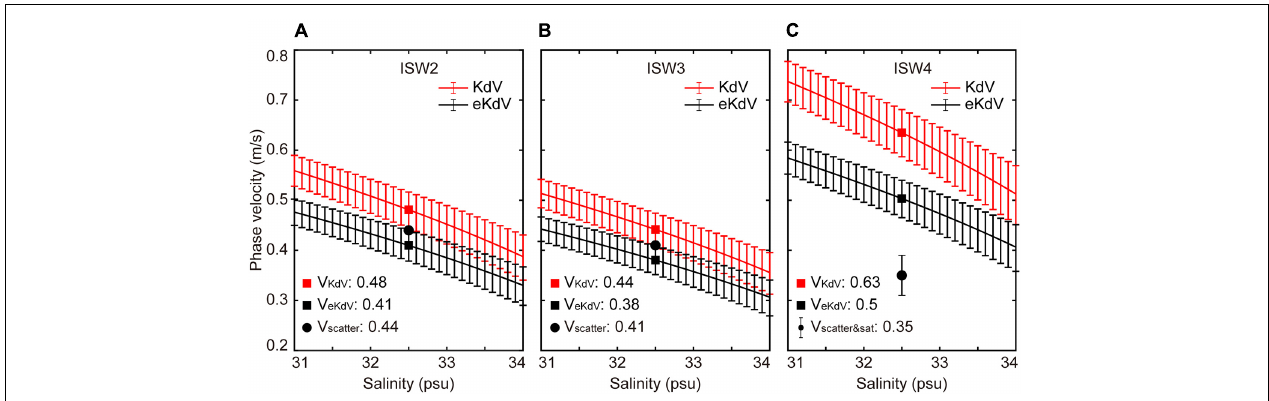
FIGURE 8 | Phase velocities of ISW2 (A) , ISW3 (B) , and ISW4 (C) derived from the two-layer KdV (red) and eKdV (black) models with different salinity parameters of the upper layers (curves with error bars). The solid squares represent phase velocities calculated using the median densities of two layers shown in Figure 6C . The solid black circles and solid black circle with error bar indicate the phase velocities of the ISW packets derived from acoustic backscatter data and satellite and acoustic backscatter data, respectively.